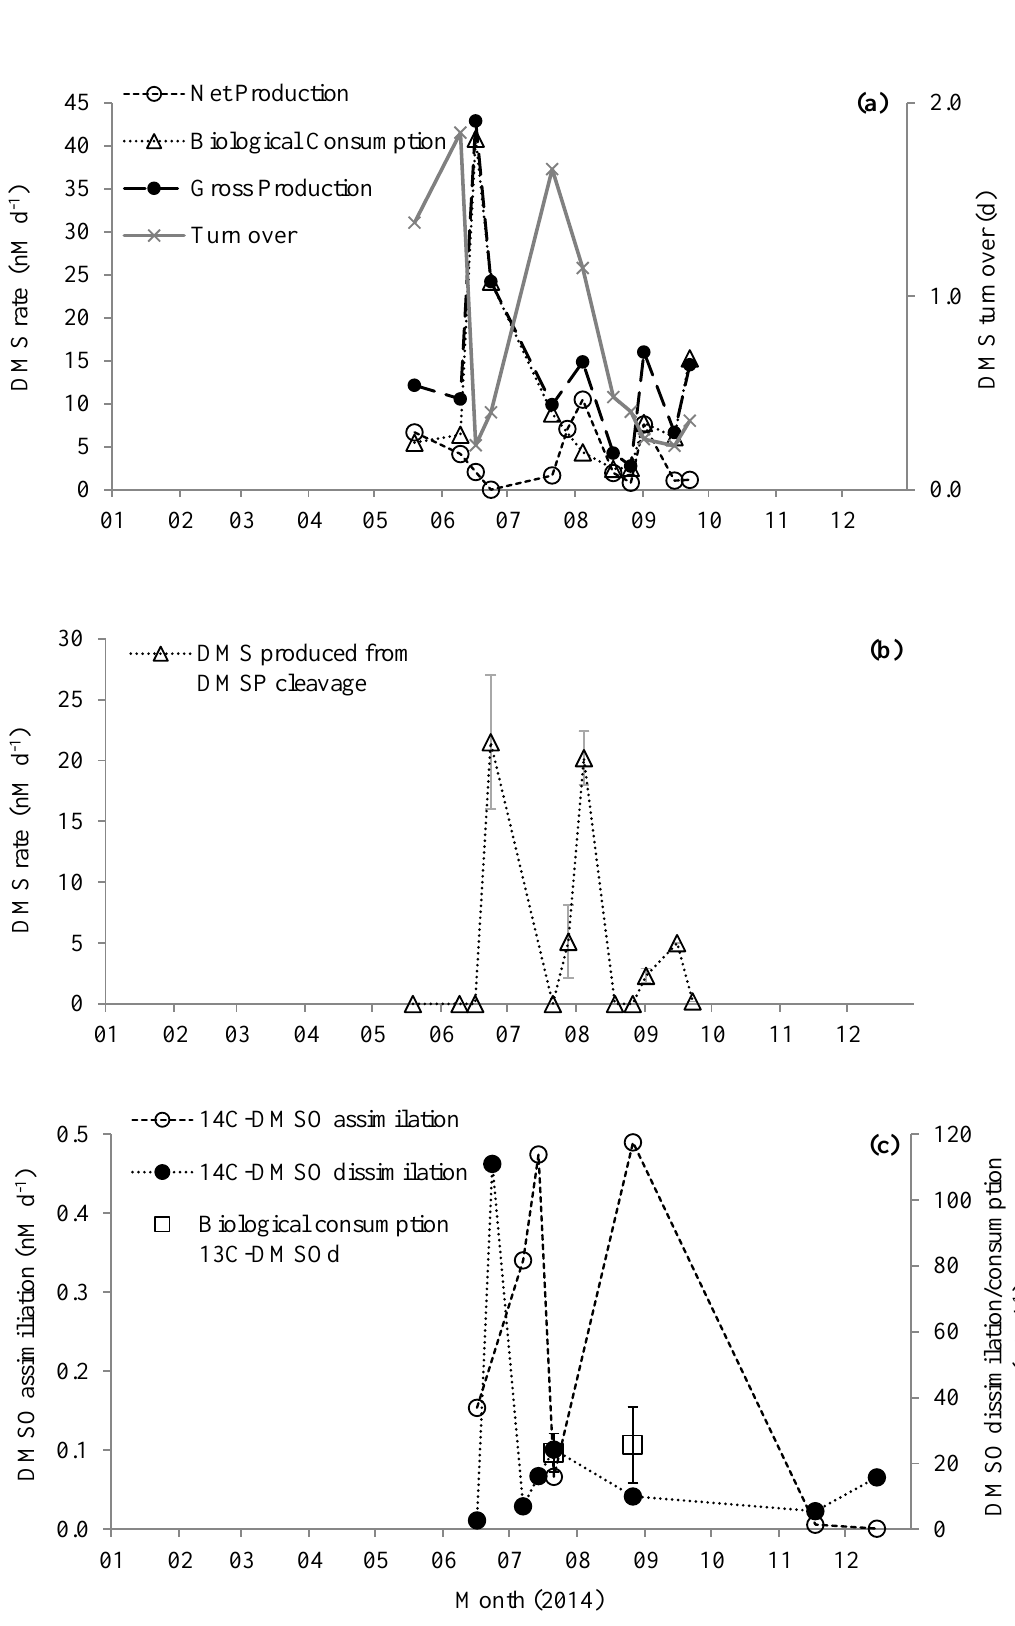
Figure 4. Changes in rates of ( a ) production and consumption of DMS and turn over time, ( b ) DMS produced from the cleavage of DMSP, and ( c ) microbial utilization of DMSO in surface waters at station L4. Error bars represent ±1 standard deviation based on three replicates.